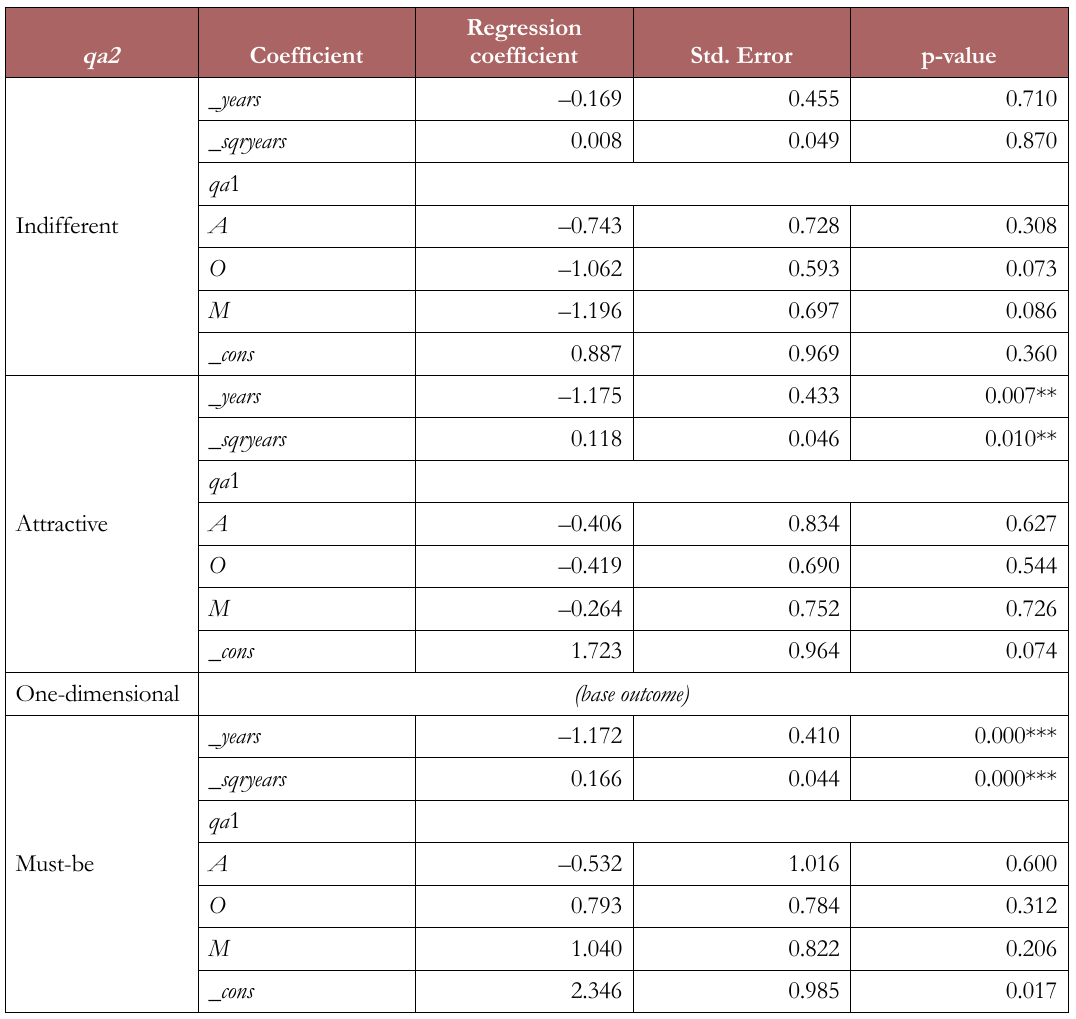
Table 2. Outcomes of the multinomial logistic regression that links log odds of designated quality attributes for a given customer requirement in two different Kano surveys, where time elapses from the previous to the subsequent one; *, ** and *** stand for significance levels corresponding to p-values minor than 0.05, 0.01